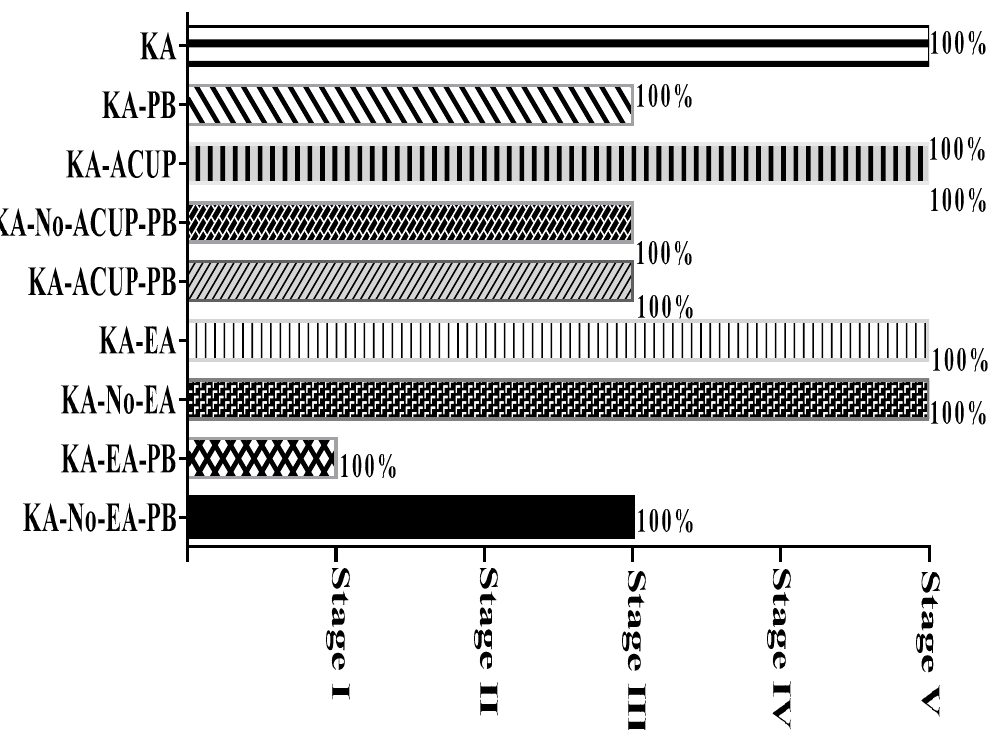
Figure 2. Graph showing convulsive activity during the application of the treatments, where groups KA, KA-ACUP, KA-No-ACUP, KA-EA, KA-No-EA maintained a phase V response; the KA-PB, KA-ACUP-PB, KA-No-ACUP-PB, and KA-No-EA-PB groups presented a phase III response; and the